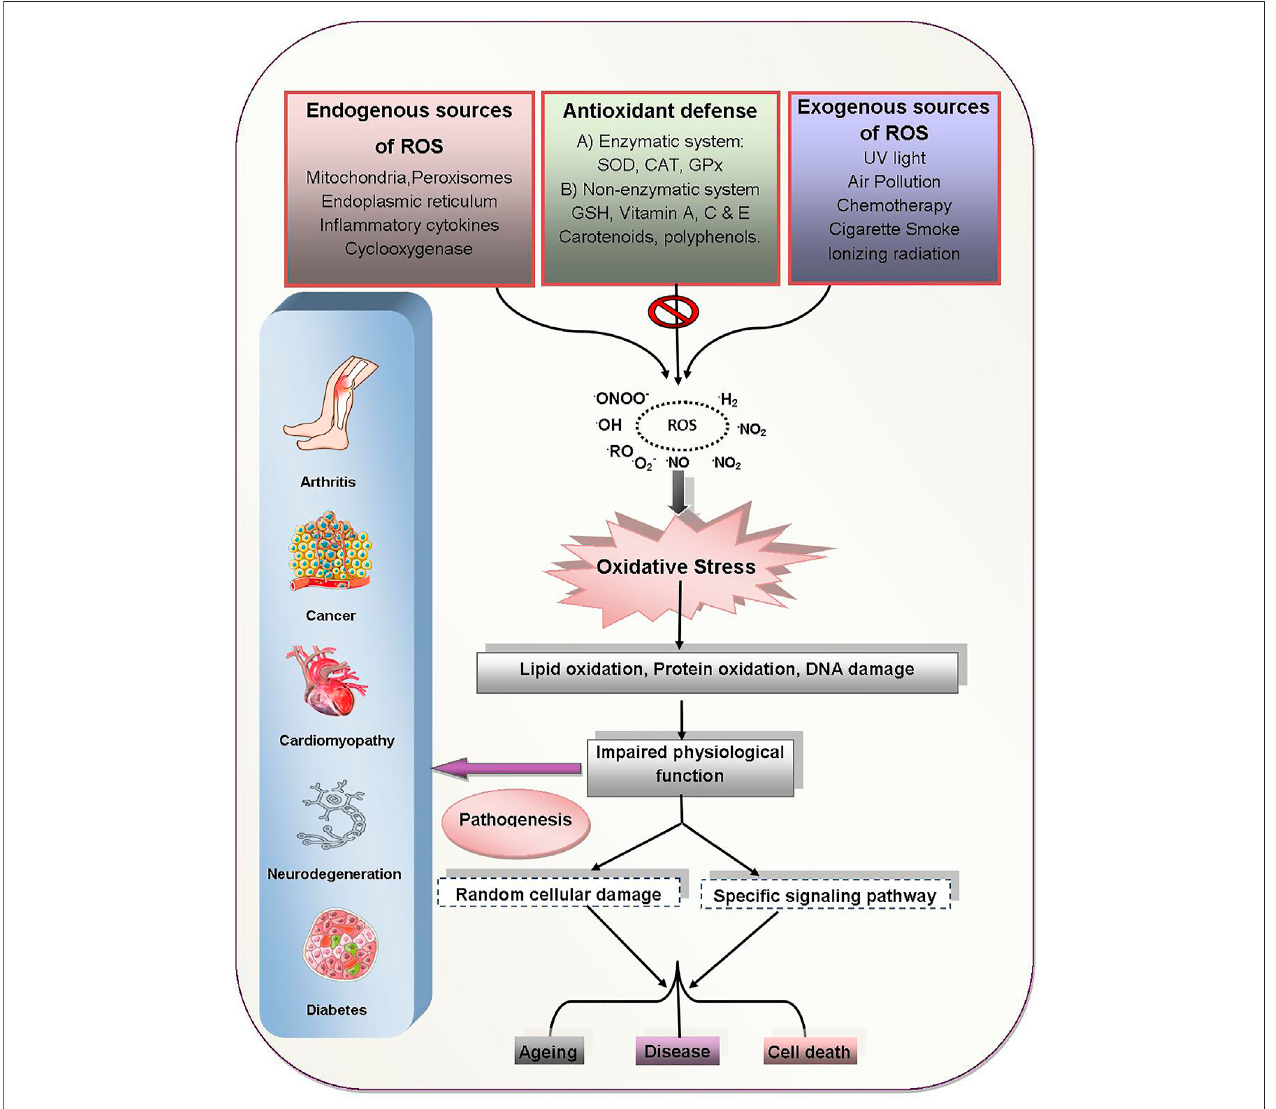
FIGURE 2 | OS induced human diseases and their pathogenesis. ROS generated from exogenous/endogenous sources induce OS which results in the pathogenesis of various human diseases through impaired physiological functions, cellular damages and speci fi c signaling dysfunctions. Abbreviations: ROO: alkoxyl (cid:129) (cid:129) − radical, ROO: peroxyl radical, ONOO − : perooxynitrite, NO 2 : nitrogen dioxide radical, O 2 : superoxide radical, ROS: reactive oxygen species, SOD: superoxide dismutase, CAT: catalase, GPx: glutathione peroxidase, GSH: glutathione.